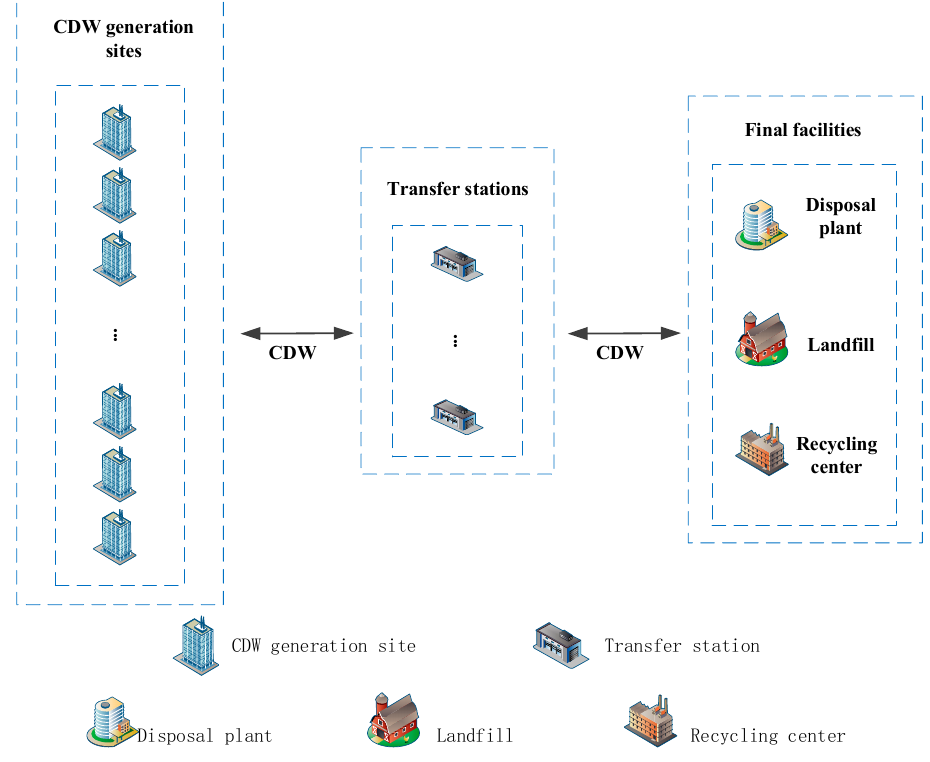
Figure 1. Collection system for reverse logistics of